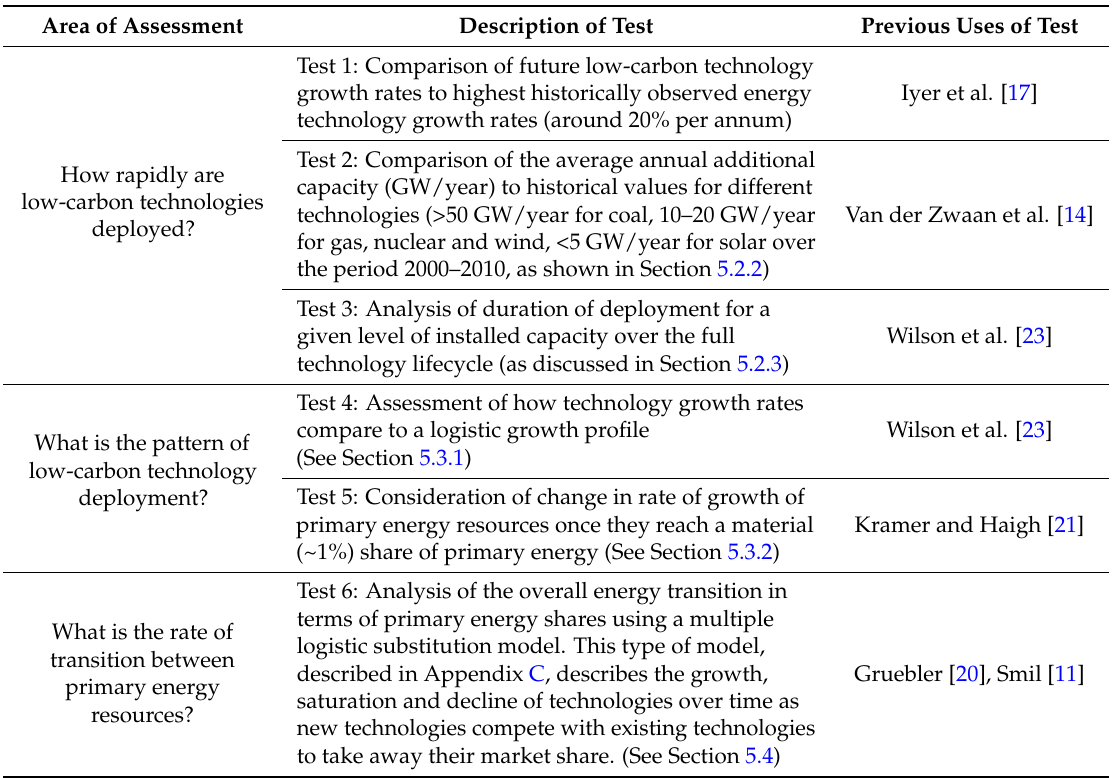
Table 3. Proposed tests to assess the feasibility of low-carbon